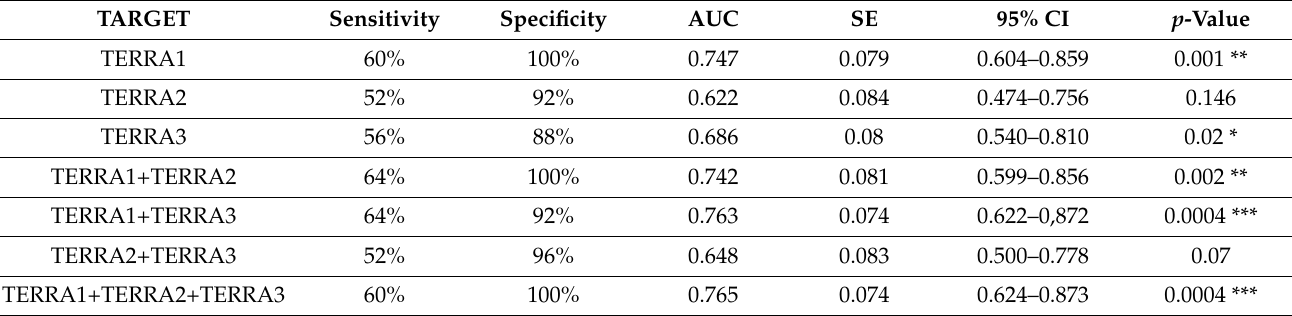
regression model of TERRA classifiers evidenced the significant combined use of TERRA targets (Figure 4d and Table 2) (AUC:0.765; CI:0.624–0.873; p -value = 0.0004). To support these findings, we calculated the average Ct values of TERRA in the 2 groups of individuals and we obtained significantly higher levels in plasma from HCC patients in comparison to healthy control subjects (Figure S2, p -value = 0.038). Further, we evaluated the correlation by Spearman’s analysis of TERRA levels between the HCC tissues and the